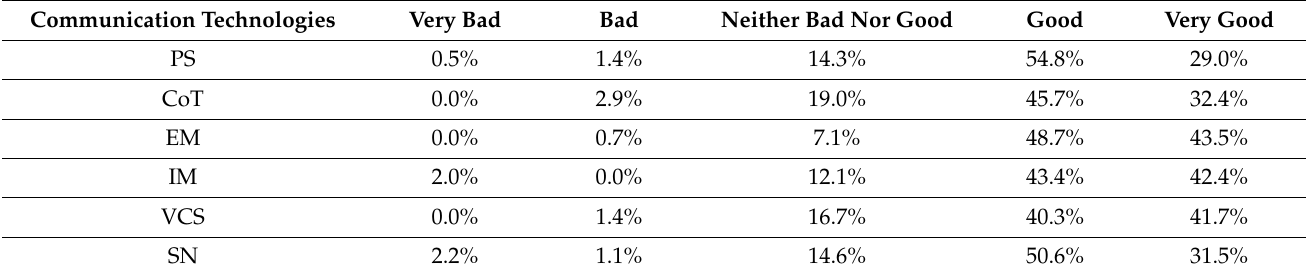
Table 13. Performance (attitude) in the use of communication technologies by students. Communication Technologies